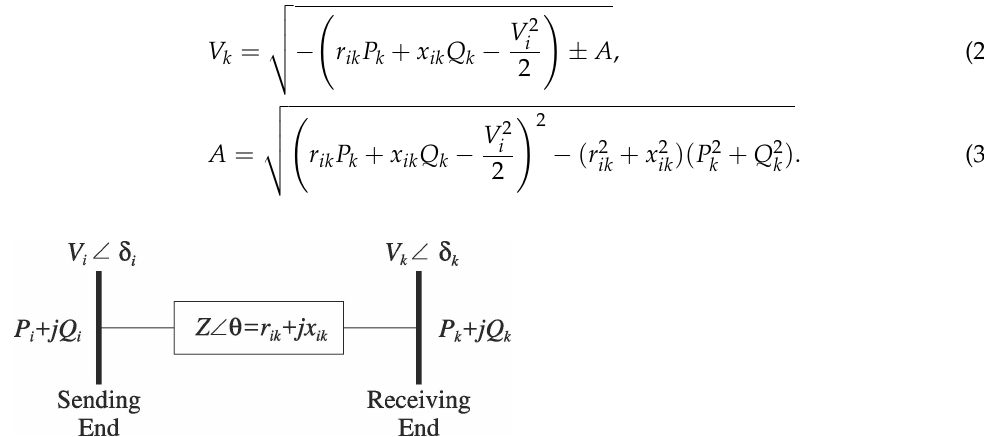
Figure 1. 2-bus transmission line model. (From Ref. [15] ).